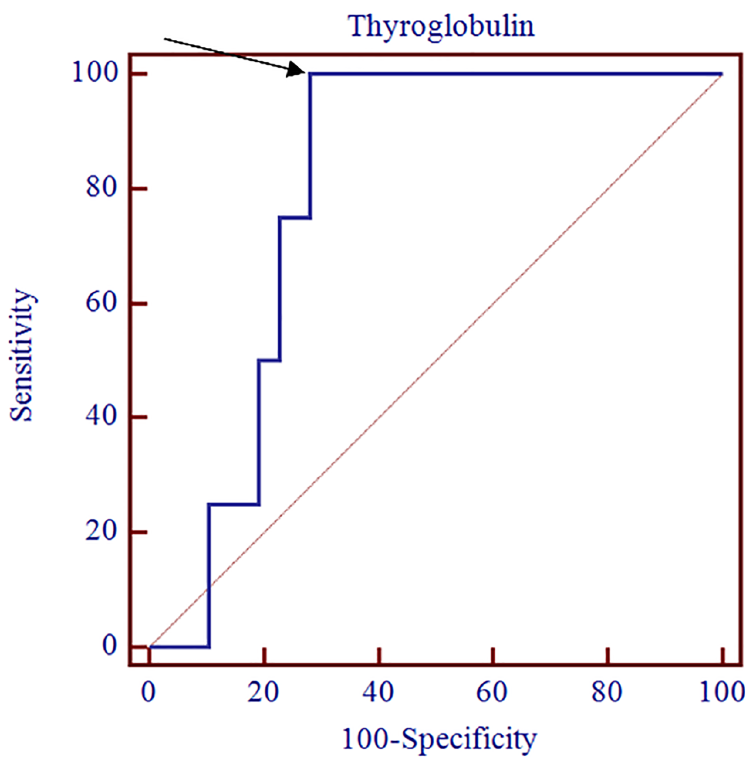
Fig 4. Receiver-operating-characteristics (ROC) curve analysis for preablation TSH-stimulated serum thyroglobulin level of RAI avid metastatic lymph node on SPECT/CT in low-risk group. The optimal cut-off of TSH-stimulated serum Tg level for predicting RAI-avid mLN in the low-risk group was 1.0 ng/ml (sensitivity, 100.0%; specificity, 71.9%; area under the curve, 0.798; p = 0.039).